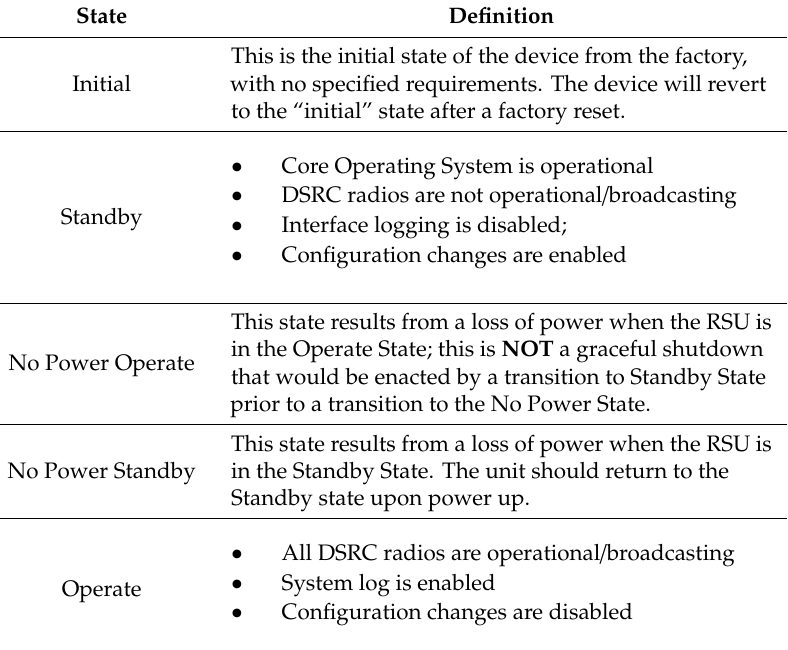
Figure 6. RSU State Diagram [28]. Table 4. RSU’s Operational States and State Transitions [28].